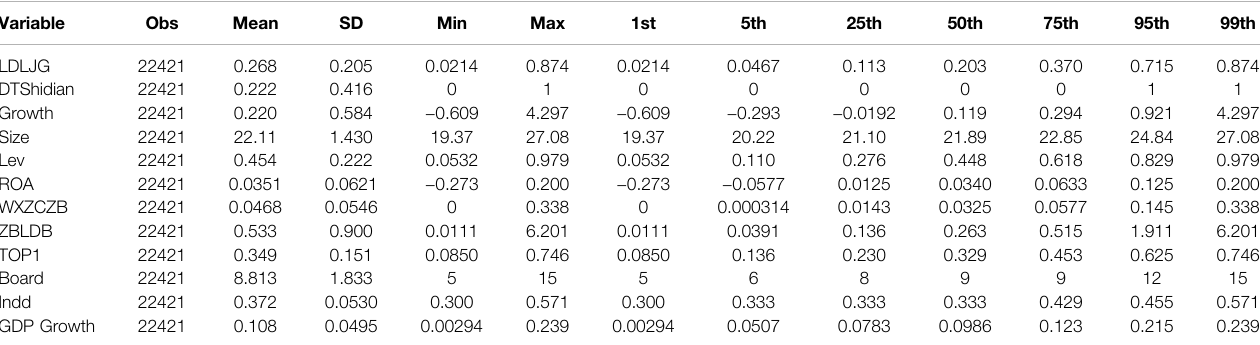
TABLE 3 | Descriptive statistics of variables.